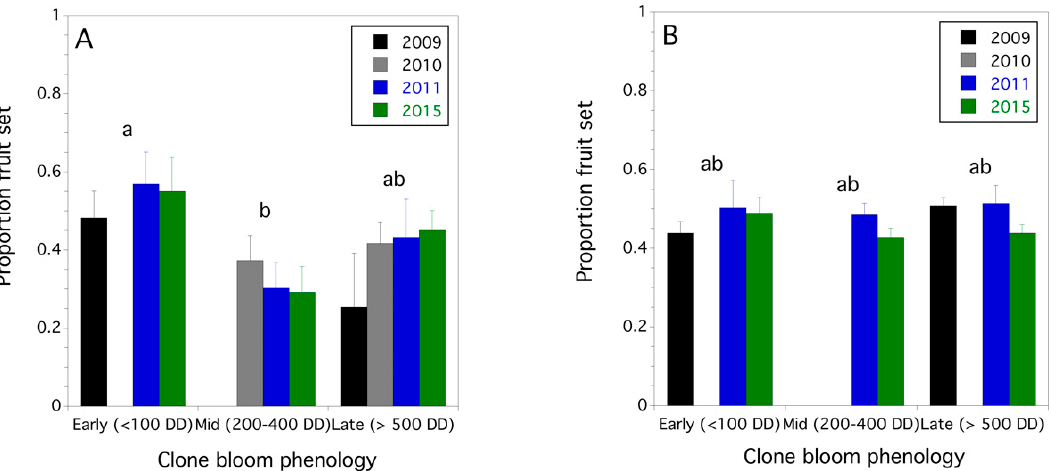
Figure 2. Overall proportion fruit set as a function of clones initiating bloom at different bloom phenological periods for hand self-pollination ( A ) and open pollination ( B ). Letters associated with bloom phenology classes that are the same are not significantly di ff erent (Tukey HSD, α = 005).